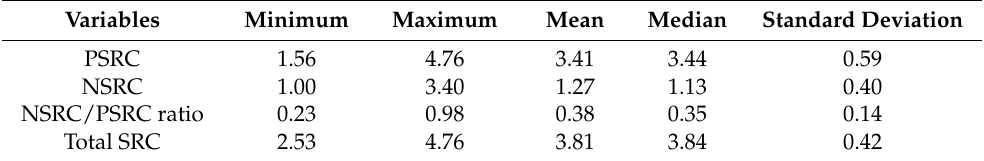
Table 1. Distribution of the participants of a rehabilitation center for mastectomized women, according to the values of Positive Spiritual/Religious Coping (PSRC), Negative Spiritual/Religious Coping (NSRC), NSRC/PSRC ratio, and Total Spiritual/Religious Coping (SRC) scores. Ribeir ã o Preto, SP, Brazil, 2013–2014 ( n =